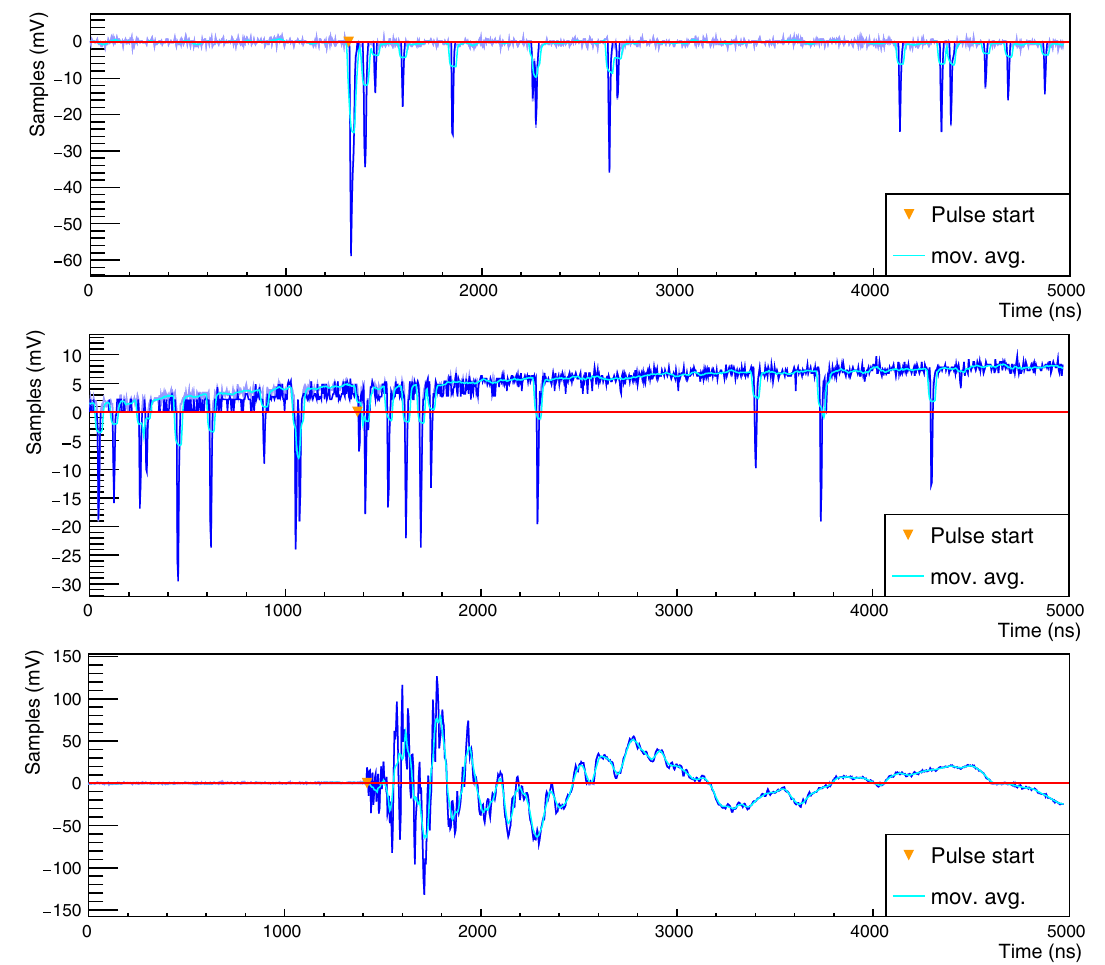
Fig. 3 Examples of events rejected by the data quality cuts. (Top) tail-event following a high energy interaction. (Center) event with anomalous baseline estimation. The baseline is shown in red. (Bottom) bipolar event